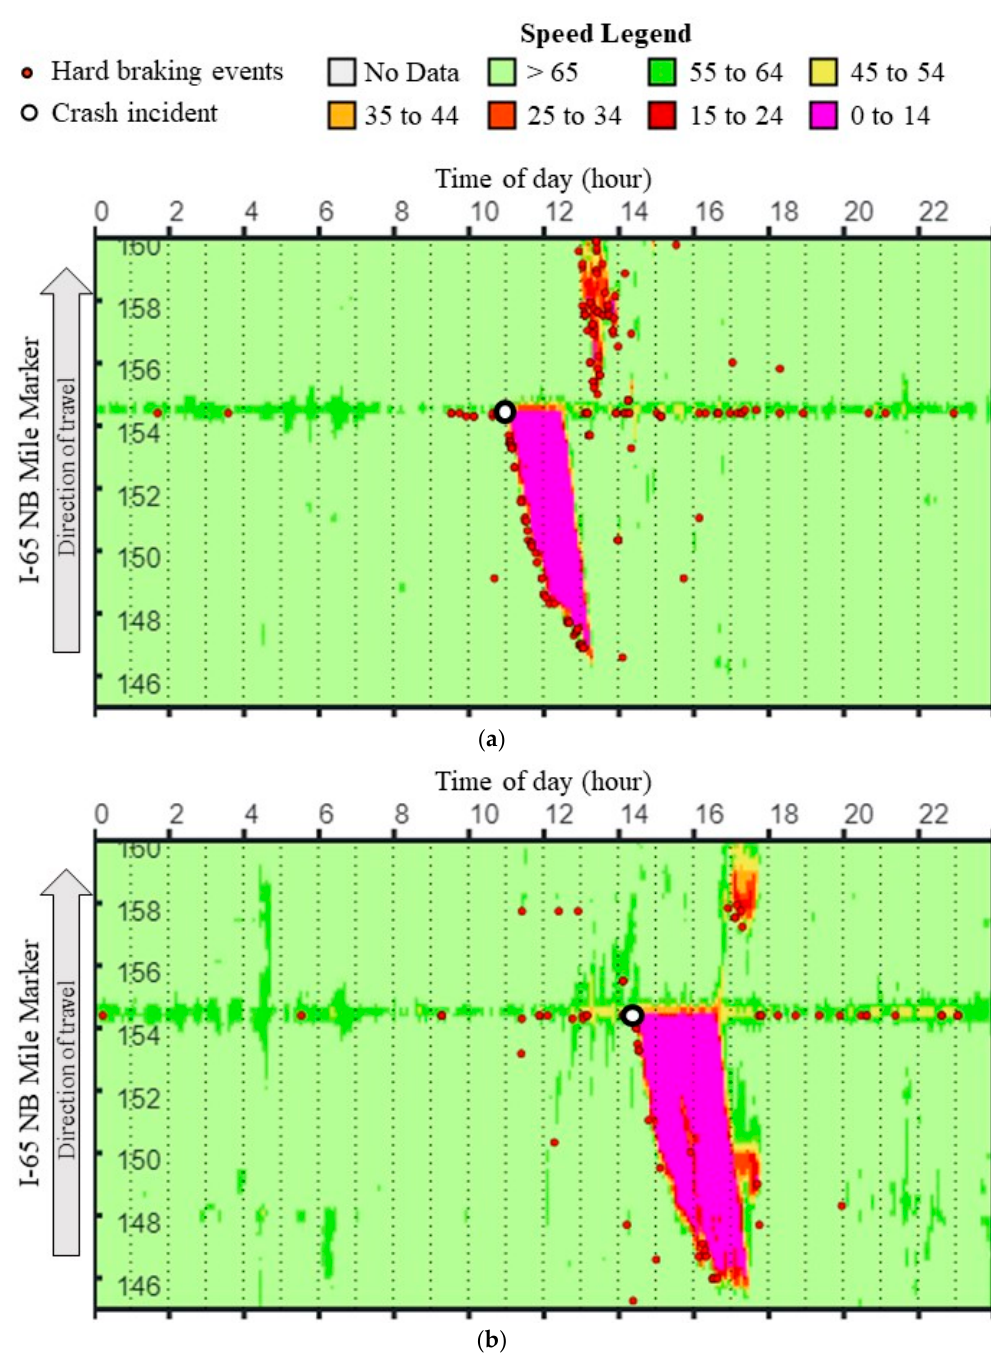
Figure 18. Crash incidents at during the lane shift on interstate. ( a ) Sunday, 4 April 2021; ( b ) Sun-